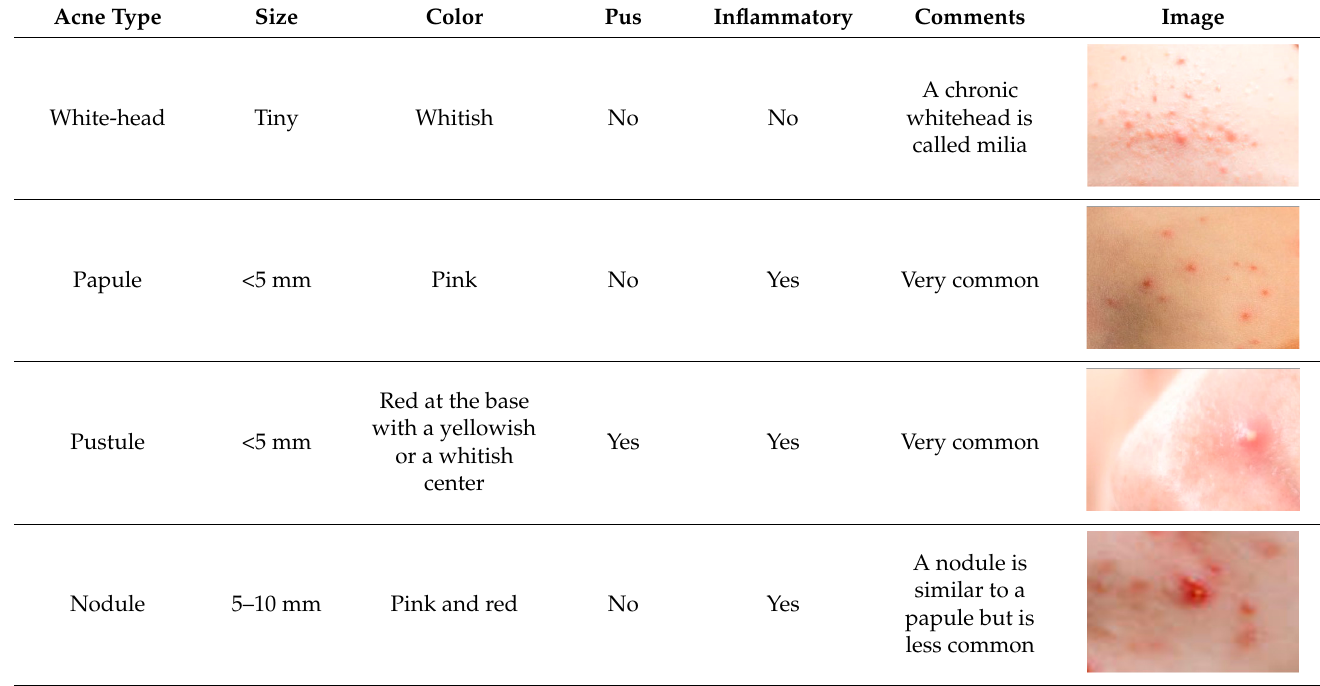
Table 2. Types of common acne in training sets [18].